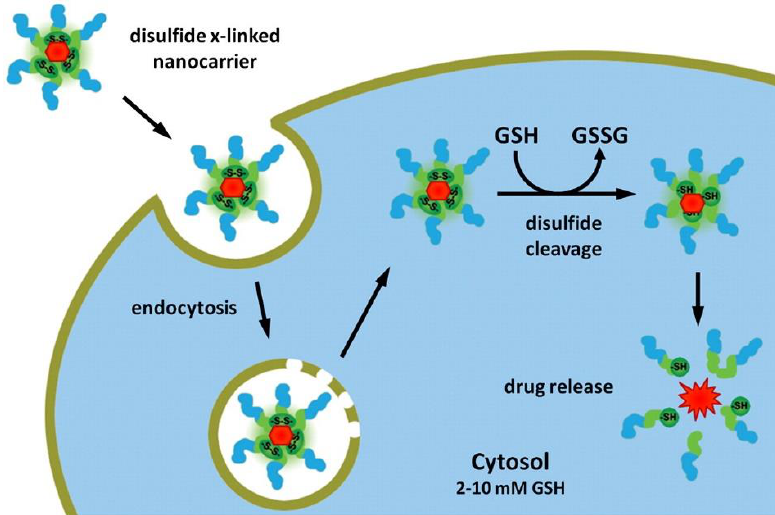
Figure 2. Schematic illustration of nanocarriers in the redox-responsive mechanism. The drug-carrying nanocarriers enter the cell through the endocytosis process. Glutathione (GSH) reduces the disulfide bonds after approaching the cytosol and subsequently erupts and releases the drug. Reprinted from Fleige et al. [18], with permission from Elsevier. Copyright (2012) Elsevier B.V.